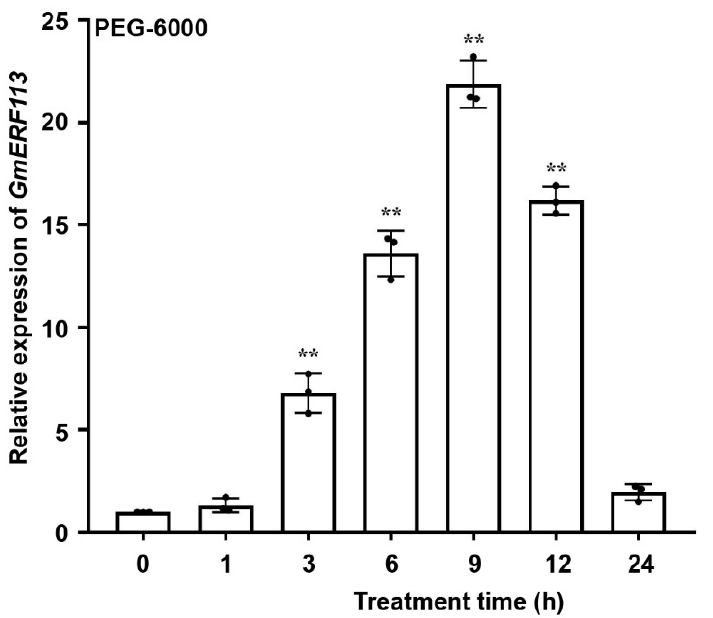
Figure 1. GmERF113 is induced by drought. Expression patterns of GmERF113 of soybean seedlings at the V2 stage were examined with 20% PEG-6000 treatment. The first trifoliate leaf samples were collected at 0, 1, 3, 6, 9, 12, and 24 h. The reference soybean gene GmActin4 (GenBank accession no. AF049106) and GmTubulin4 (GenBank accession no. XM_003554060) were used as internal controls to normalize the data. The experiment was performed on three biological replicates, each with three technical replicates, and was statistically analyzed using Student’s t -test (** P < 0.01). The bars indicate the standard deviation of the mean.